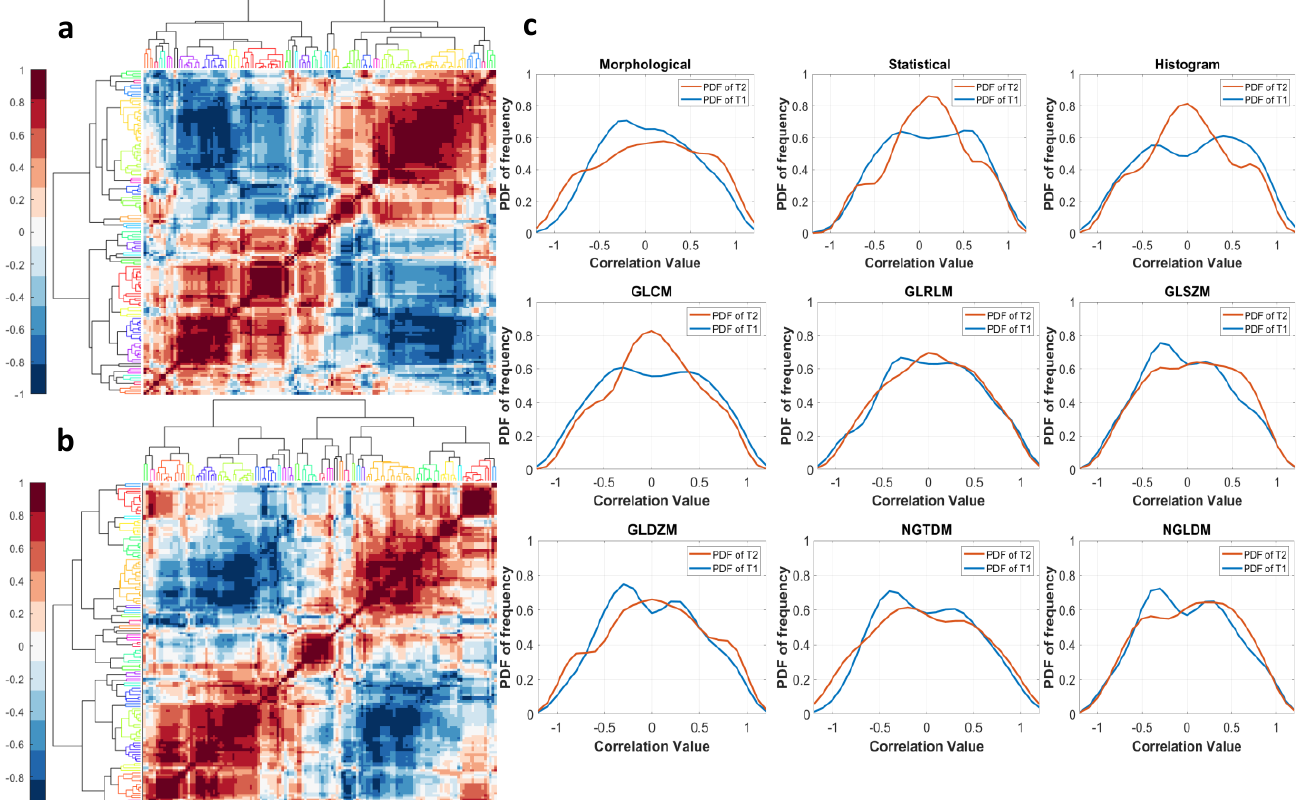
Figure 8. ( a ) Clustergram for correlation between the ∆ FeatureValues for T1w. ( b ) Clustergram for correlation between the ∆ FeatureValues for T2w. ( c ) The PDF for T1w and T2w for the distribution of the ∆ FeatureValues’ Spearman correlation coefficient by radiomic sub-category.